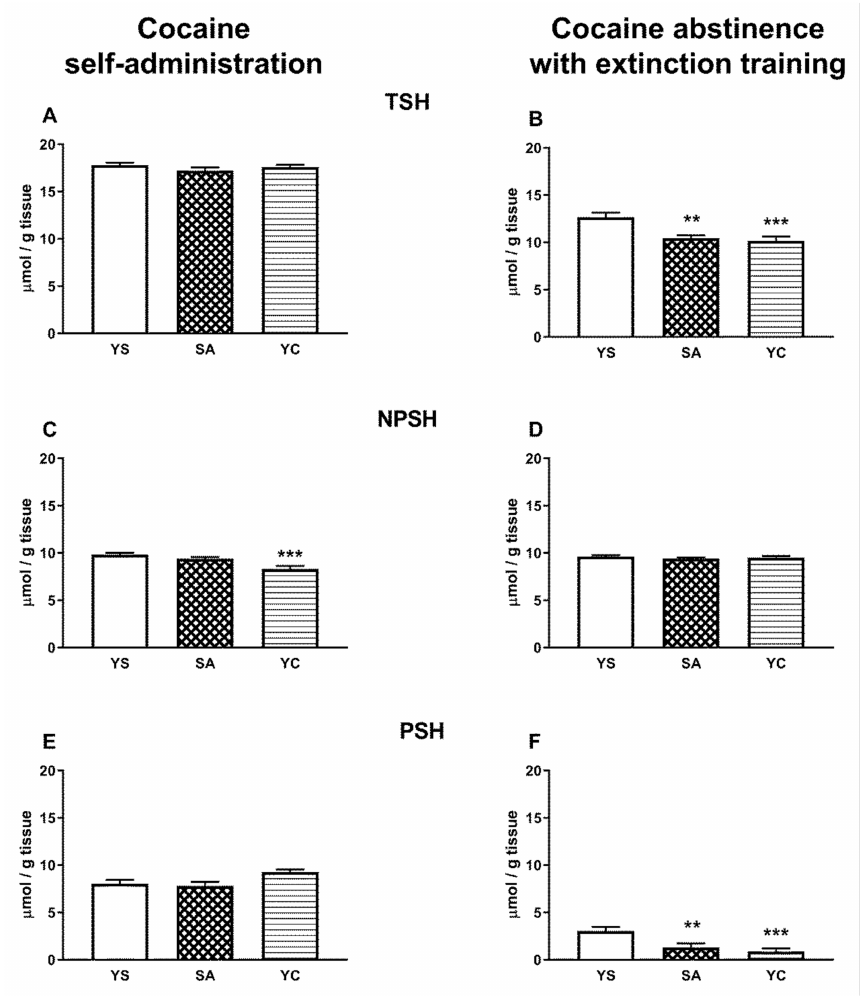
Figure 9. Levels of the total, non-protein, and protein –SH groups in the presence of cocaine ( A , C , E ) and after 10 days of drug abstinence with extinction training ( B , D , F ) in the livers of rats self- administering cocaine (SA), receiving passive cocaine infusions (YC), and receiving saline infusions (YS): data are presented as the mean ± SEM, n = 8–10 per group. ** p < 0.01, *** p < 0.001 vs. YS